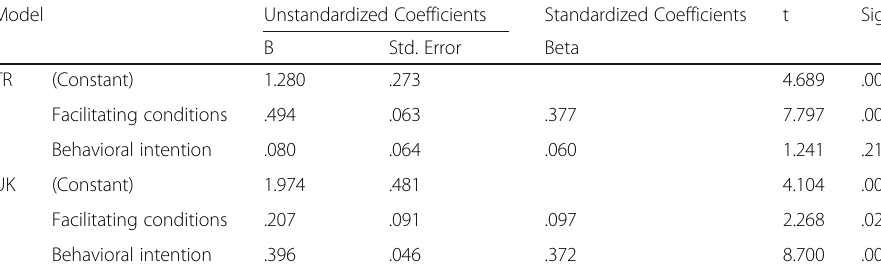
Table 5 Regression analysis